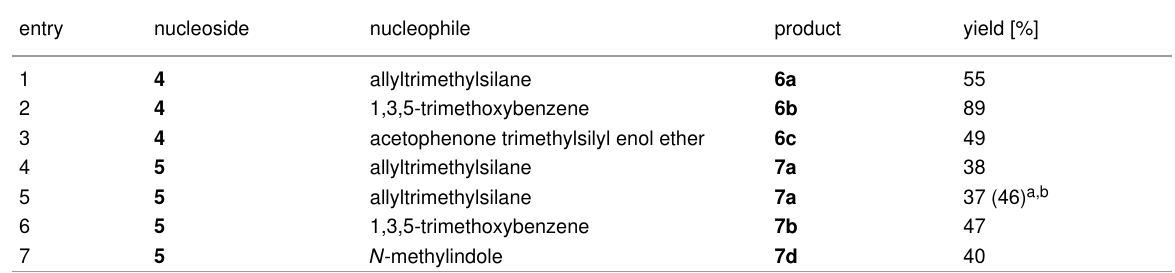
Table 1: Preparation of modified uridine dicobalt hexacarbonyl derivatives 6 and 7 via the Nicholas reaction (BF 3 ·OEt 2 , CH 2 Cl 2 , 0 °C to rt). entry nucleoside